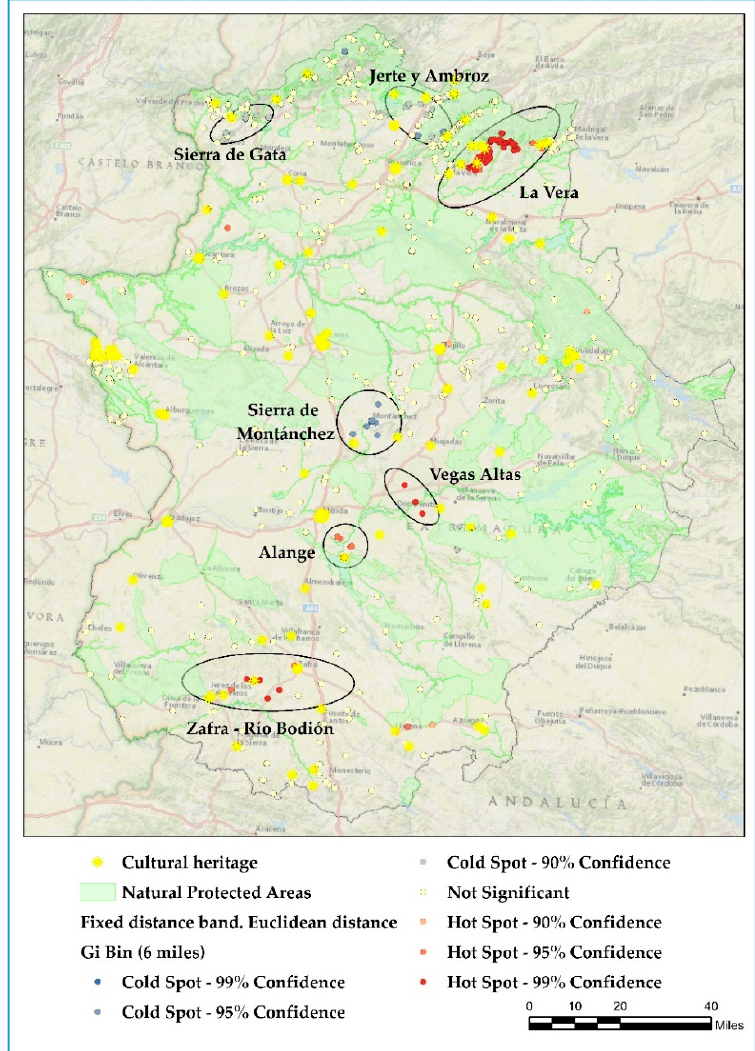
Figure 7. Hot spot analysis results.